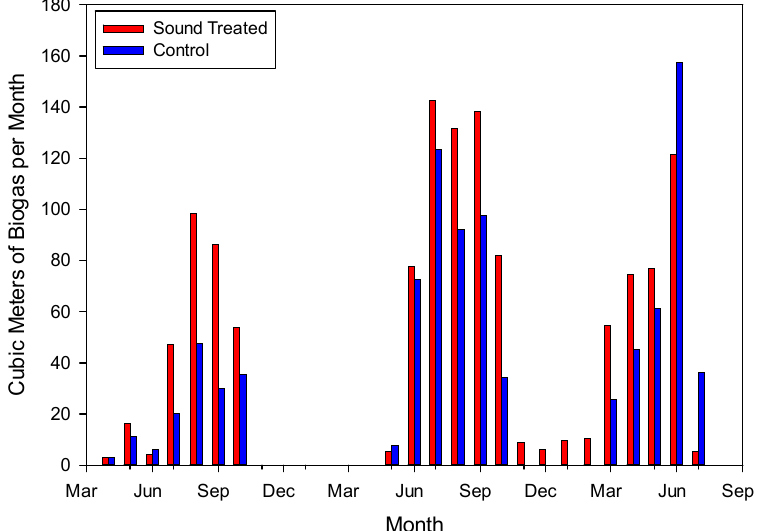
Figure 2. Average monthly gas production from the sound-treated and control anaerobic digest- ers.